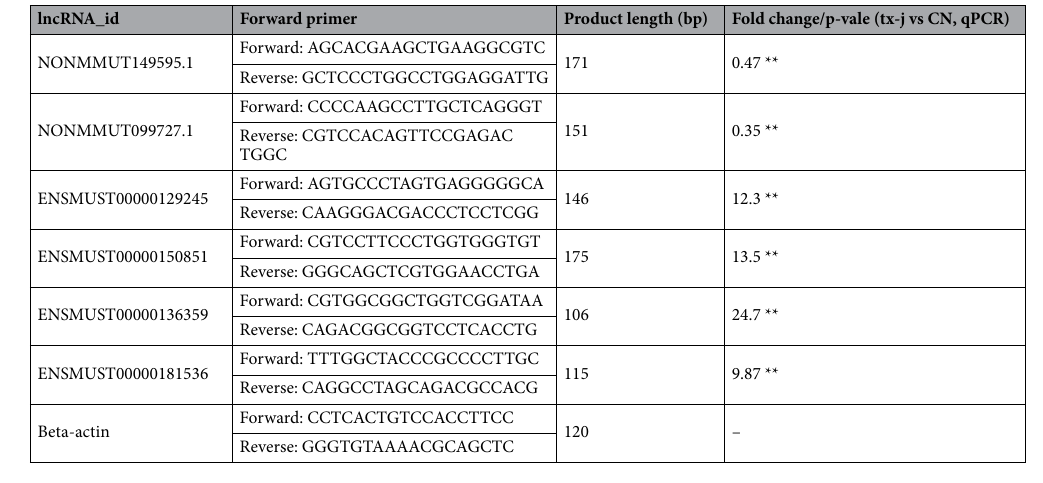
Table 1. The details of qPCR primers. **Means p <